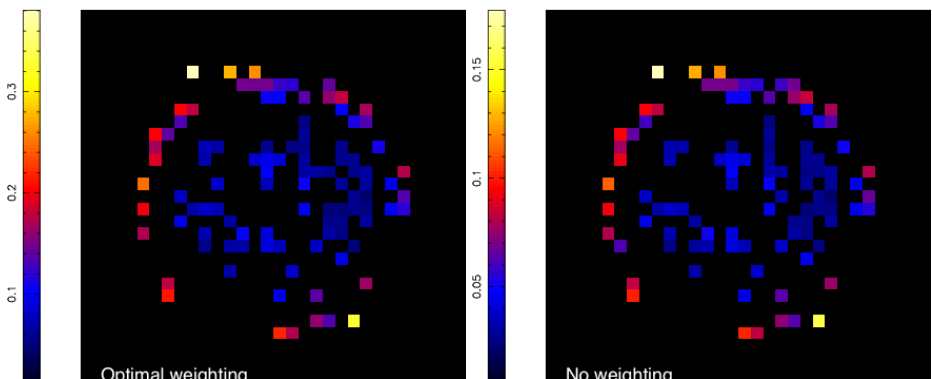
Figure 5. Monte Carlo simulations for Cassiopeia A based on 2 Ms observation with XIPE using photons in the 4–6 keV band. The pixel size is 16 (cid:48)(cid:48) . See the labels for the image identifications. The Stokes I image shows the polarisation E-vector directions, with the length of the line proportional to the polarisation fraction. For the polarisation fractions (lower two images) only pixels for which the polarisation signal to noise ratio is larger than 3 are indicated. Spurious “detections” outside the border of Cas A (see significance map) were ignored. All except the last image (lower right) are based on the weighted scheme for determining the stokes parameters. The last image gives the polarisation fraction without corrections. Visually it is similar to the image in the lower left, but its colour scaling is